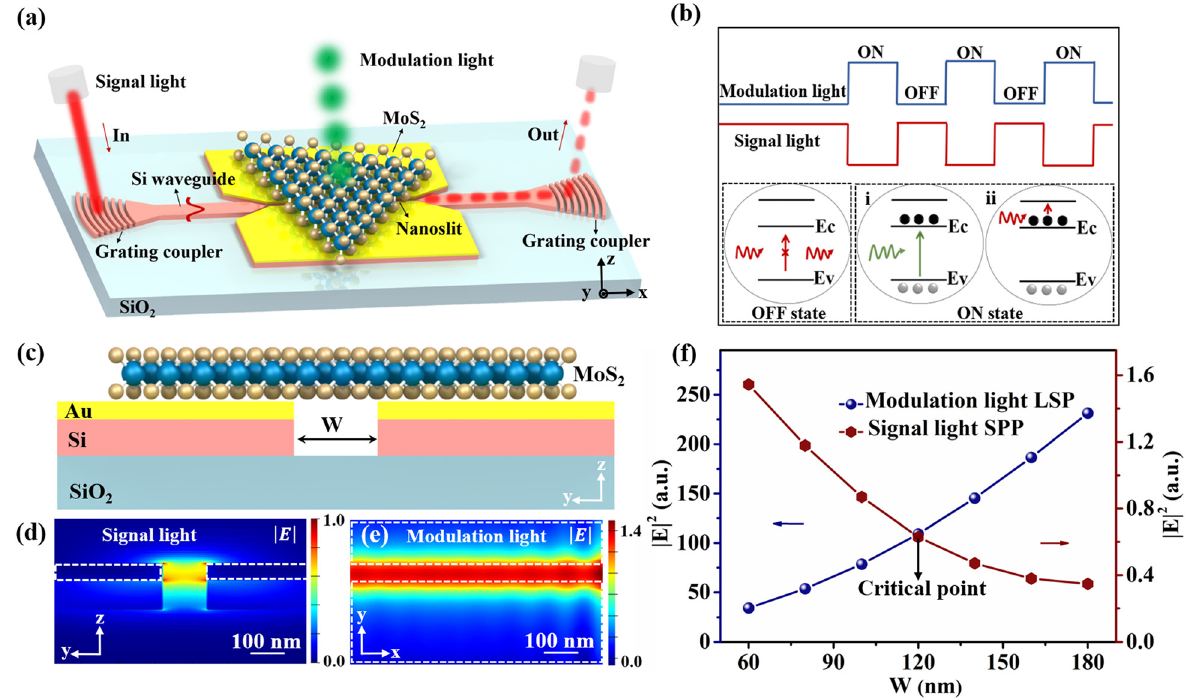
Figure 1: MoS 2 -plasmonic nanoslit all-optical modulation. (a) Schematic diagram of the device structure. (b) Working principle of the all-optical modulation. (c) Cross-sectional view of (a) (in yz plane). (d) – (e) Con fi ned electric fi eld distribution of signal and modulation lights. The slot width is 120 nm in each case, and the Au and Si layer thicknessare80and140nm,respectively.Scalebar,100nm.Thewavelengthsofthesignalandmodulationlightsaresetto1550and532nm, respectively. And the TE mode is selected. (f) Electric- fi eld energy of signal light SPP and modulation light LSP as functions of plasmonic nanoslit